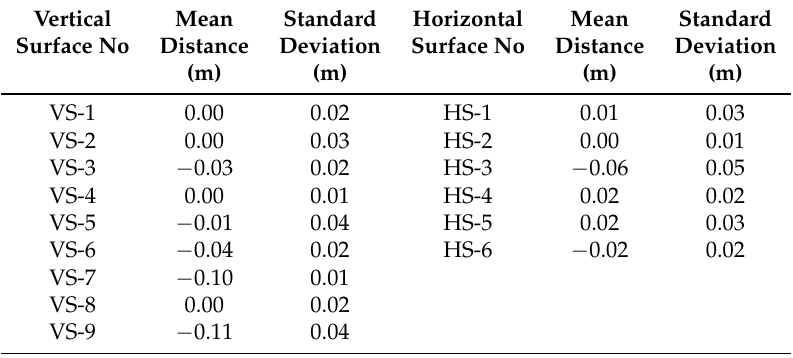
Table 3. Residuals at reference surfaces; vertical (left), and horizontal (right). Vertical Mean Standard Horizontal Mean